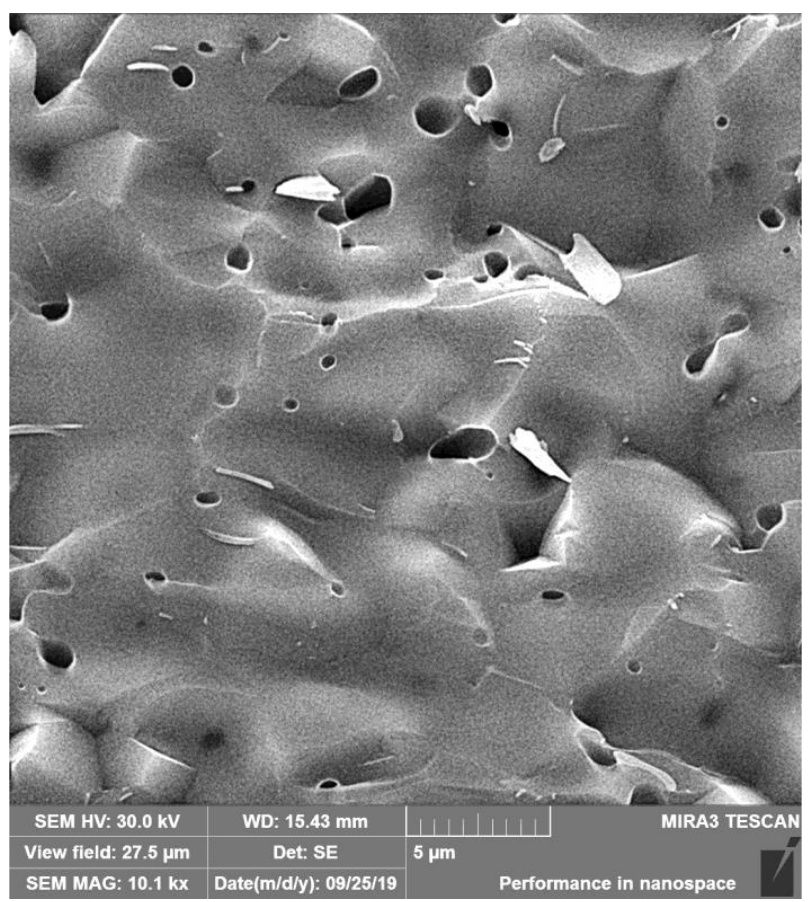
Figure 2. Microstructure of the fractured ceramic sample. A low fraction of 0.5‒2.5 µm spherical pores is visible in the microstructure.